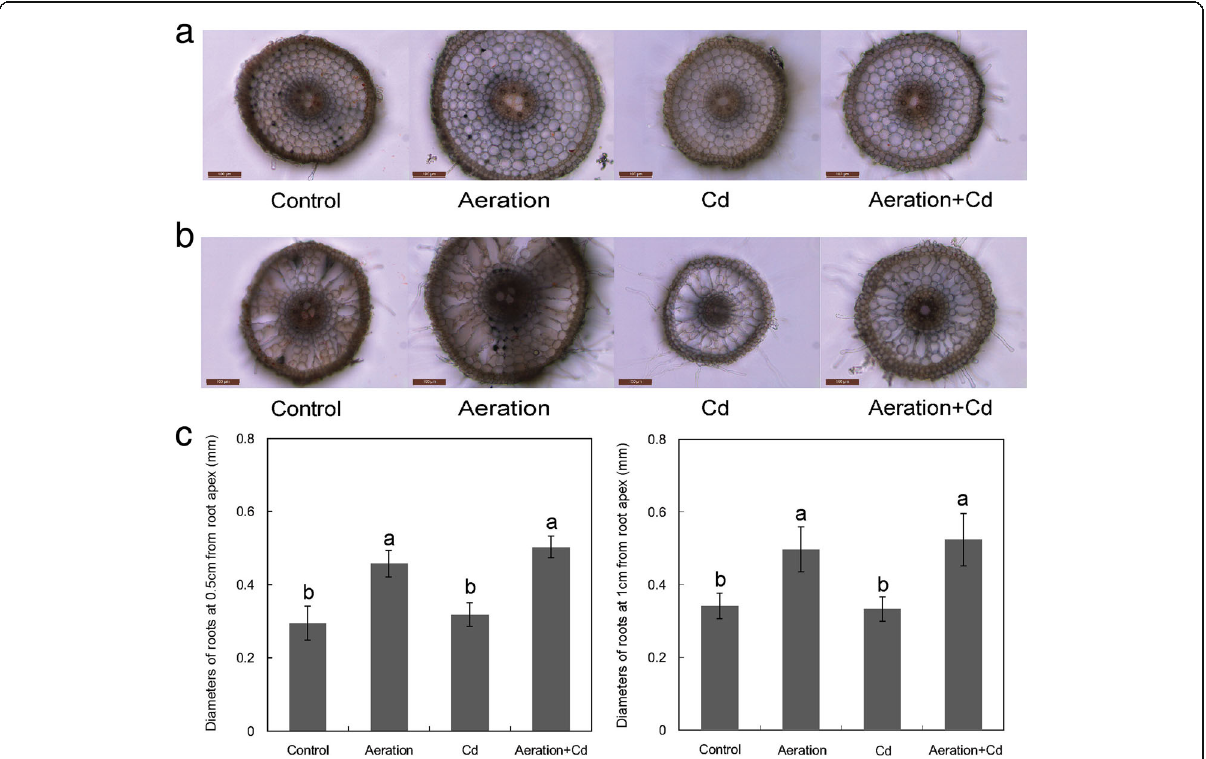
Fig. 2 Effects of aeration or/and 50 μ M CdCl 2 treatments on the structure of rice root. a Transverse section at 0.5 cm from root apex, bar indicates 100 μ m; b Transverse sections of root at 1 cm from root apex, bar indicates 100 μ m; c Diameters of roots at 0.5 cm and 1 cm from root apex. The 3-week-old rice seedlings under hydroponic culture were aerated with air pump (30 min per hour) in the absence or presence of 50 μ M CdCl 2 for 14 d. The values are means ± SE ( n = 5). Different letters on bar indicate significant differences at P <